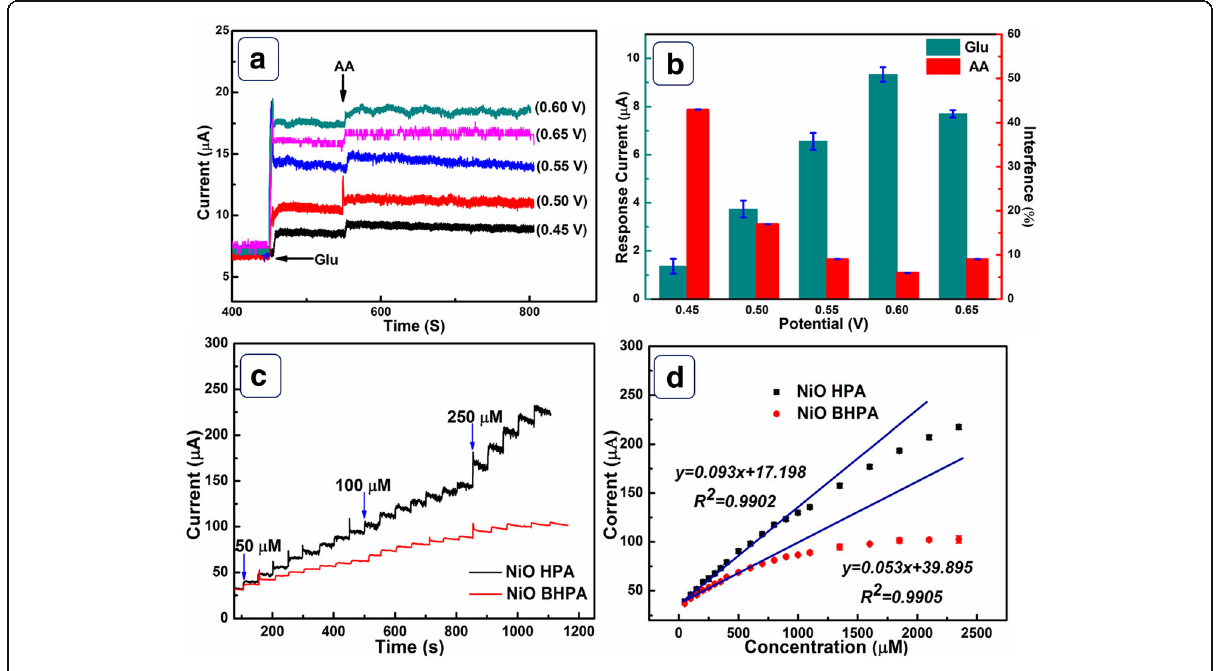
Fig. 6 a Amperometric response of NiO HPA electrode at different potentials with the addition of 0.1 mM glucose and 0.01 mM AA. b The response current of glucose and AA at different potentials. c CA of NiO HPA and NiO BHPA electrode at 0.6 V with the successive addition of glucose. d The relationship between response current and the concentration of